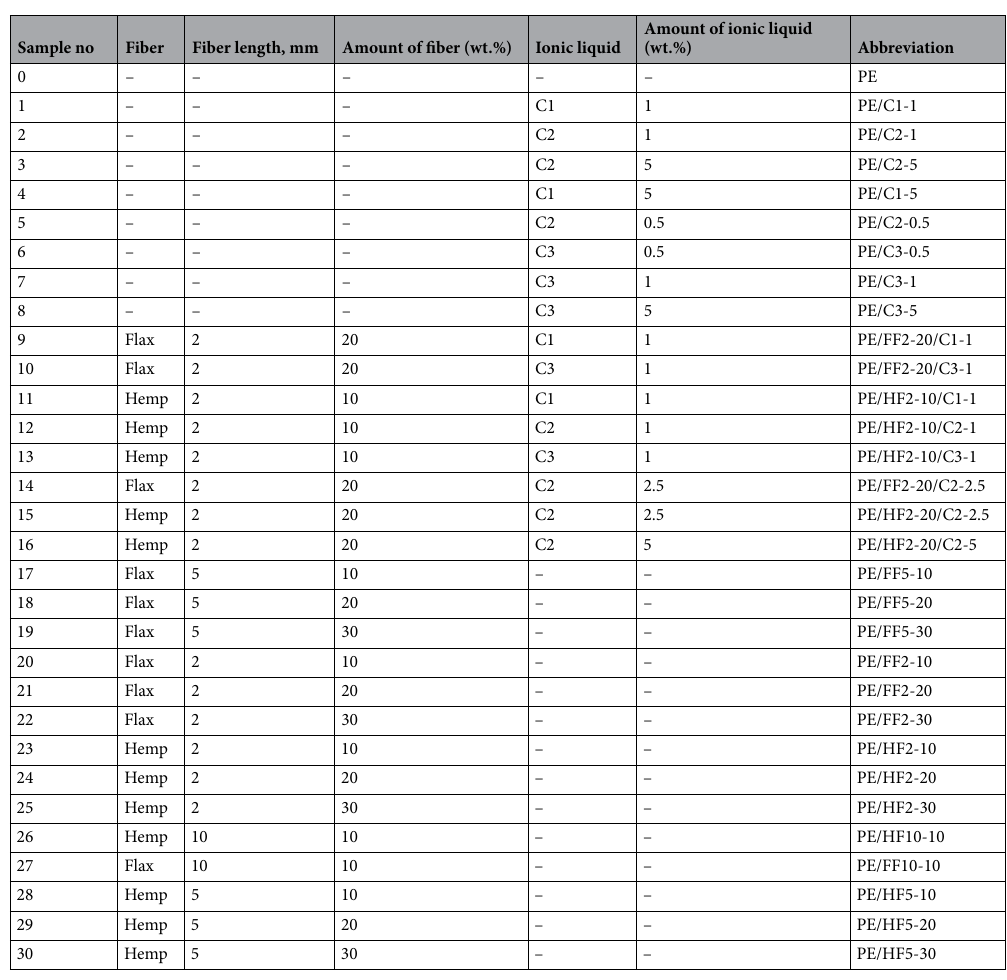
Table 2. Composition of the